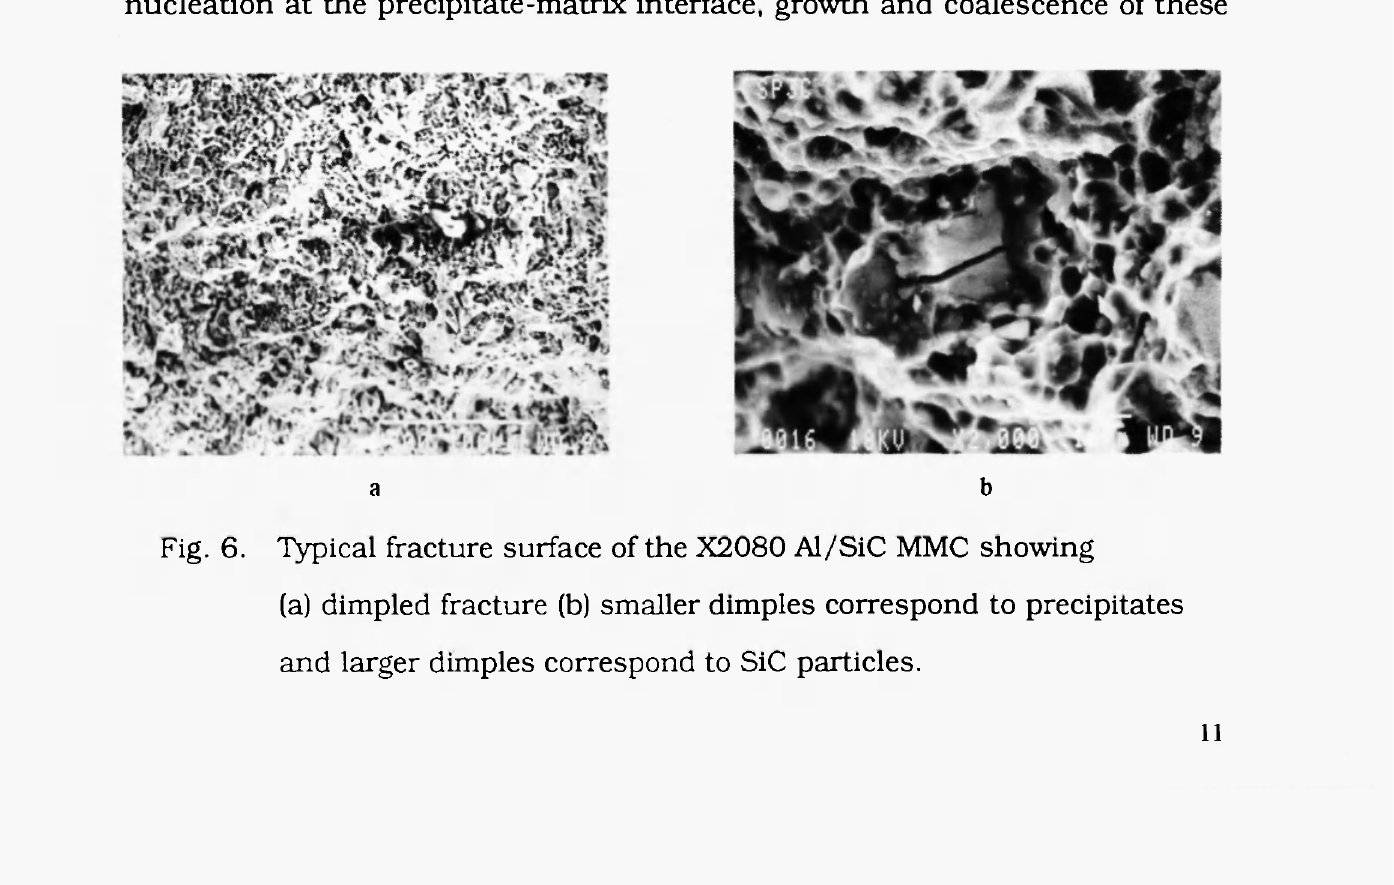
Fig. 6. Typical fracture surface of the X2080 Al/SiC MMC showing (a) dimpled fracture (b) smaller dimples correspond to precipitates and larger dimples correspond to SiC